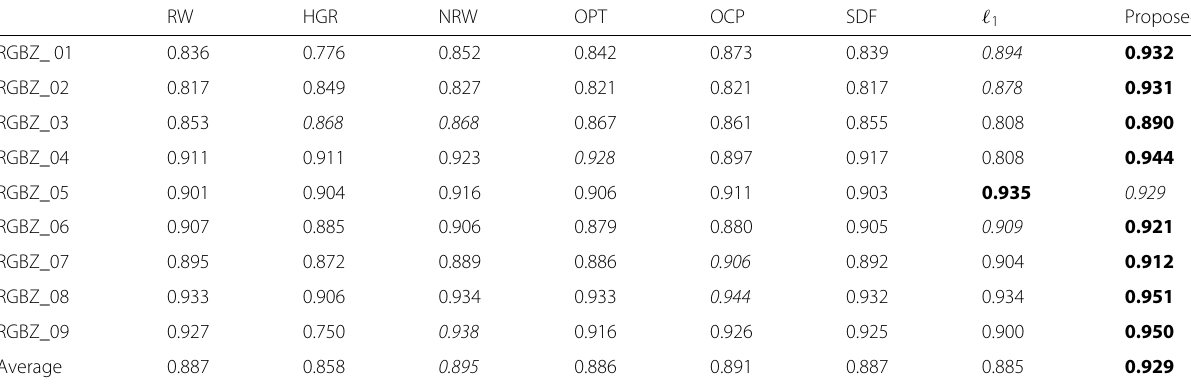
Table 1 SSIM of estimated depth on RGBZ datasets when cross-boundary scribbles are present RW